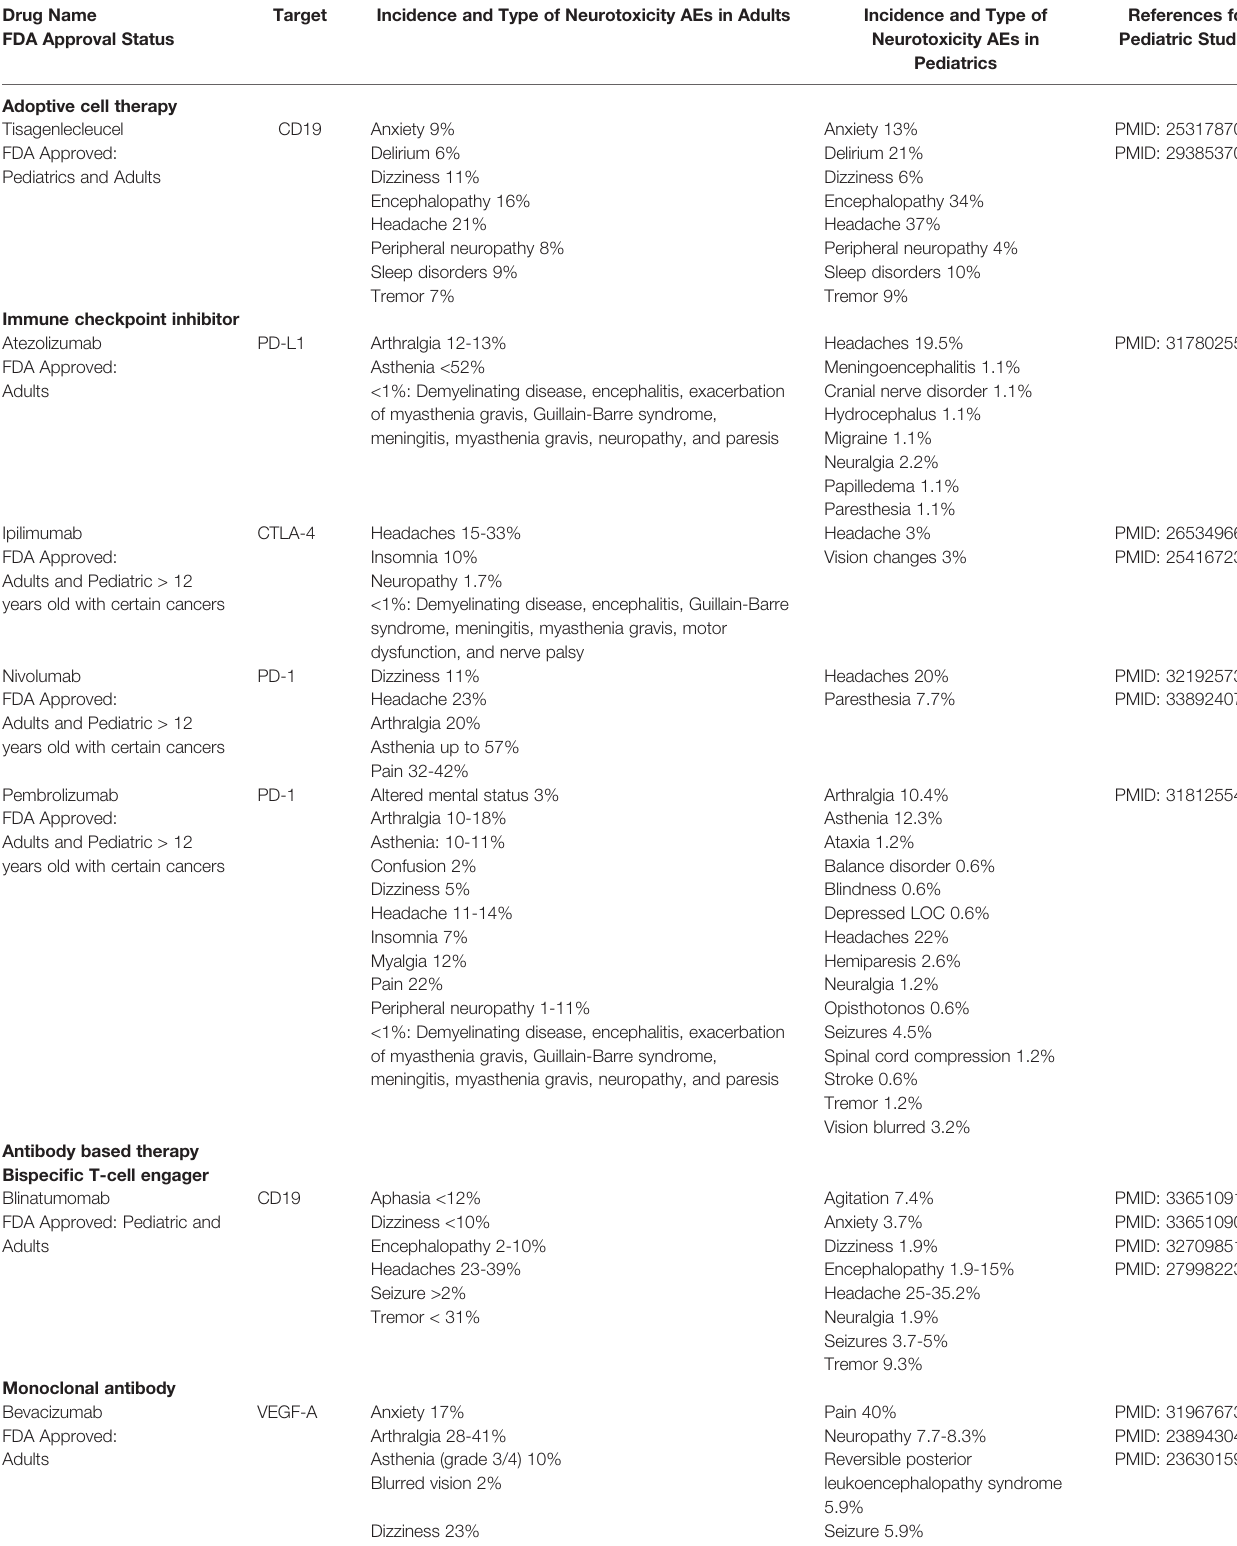
TABLE 2 | Comparison of Neurotoxicity in FDA Approved Immunotherapy agents in adults or